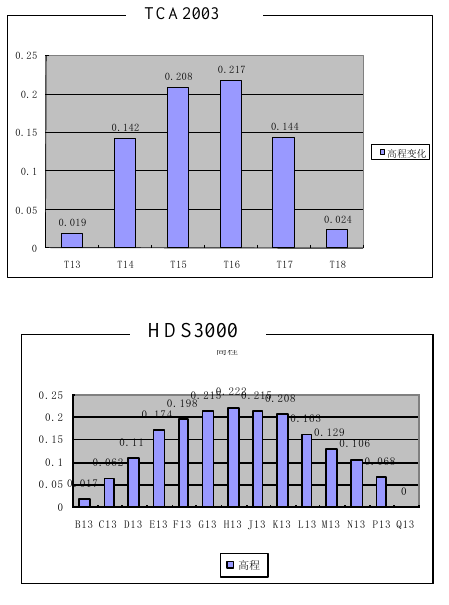
Figure11 data contrast between HDS3000 and TCA2003